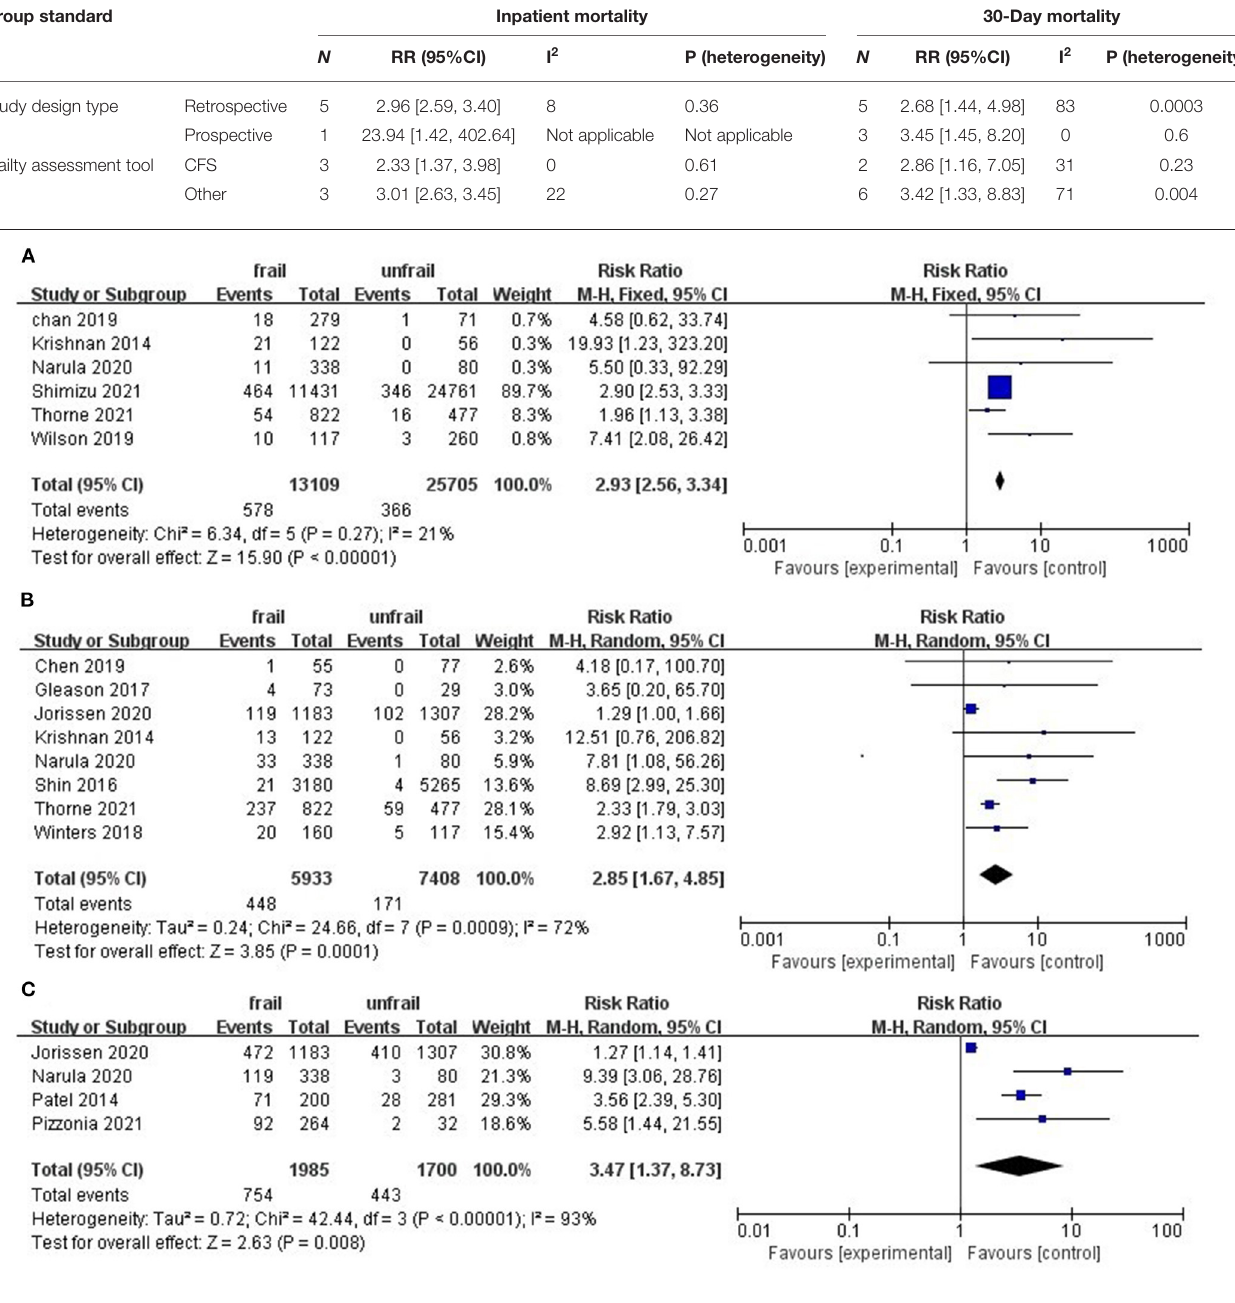
FIGURE 2 | Forest plots of frailty and postoperative mortality of hip fractures. (A) in-hospital mortality (B) 30-day mortality (C) one-year mortality.